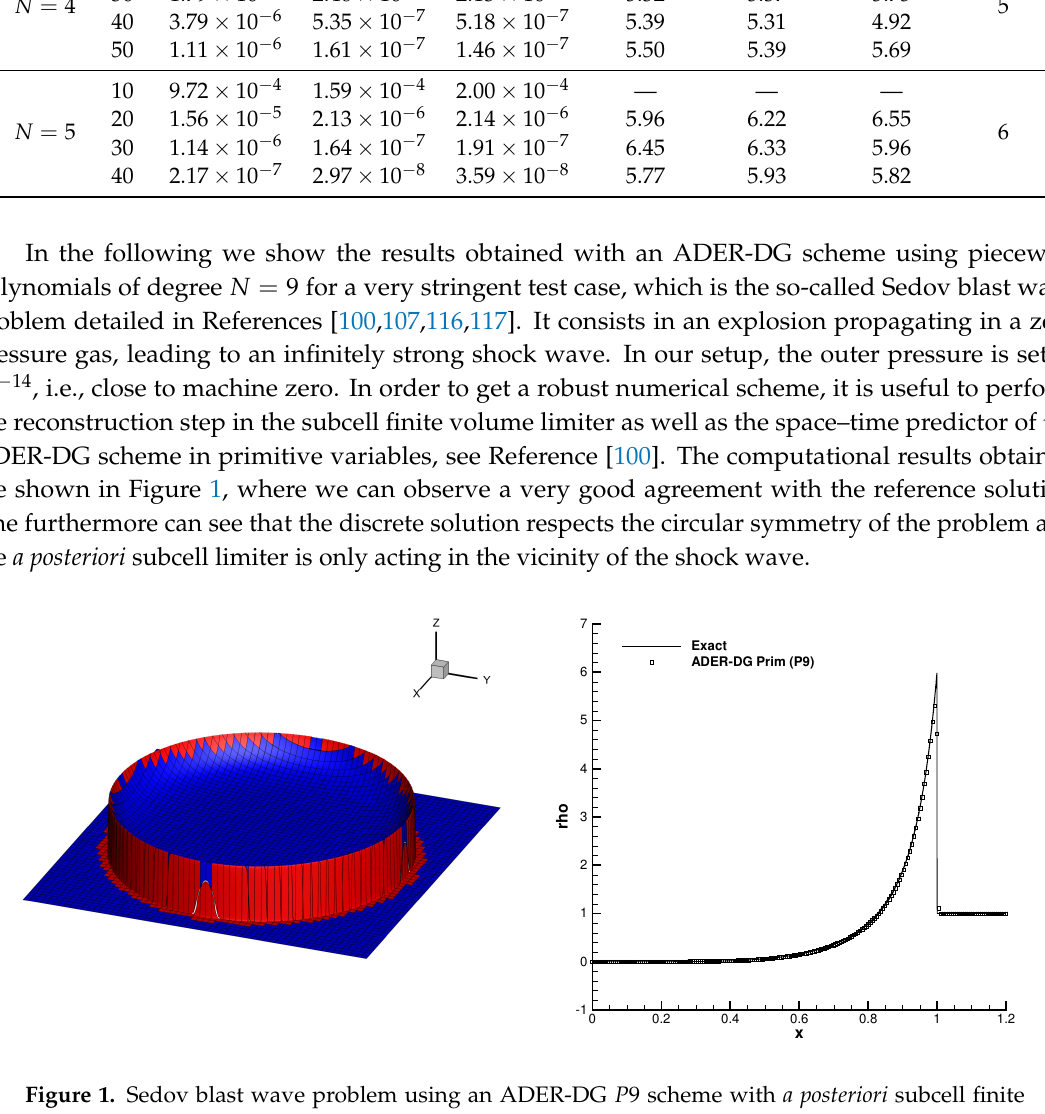
Figure 1. Sedov blast wave problem using an ADER-DG P 9 scheme with a posteriori subcell finite volume limiter using predictor and limiter in primitive variables, see Reference [100]. Unlimited cells are depicted in blue, while limited cells are highlighted in red ( left ). 1D cut through the numerical solution and comparison with the exact solution ( right